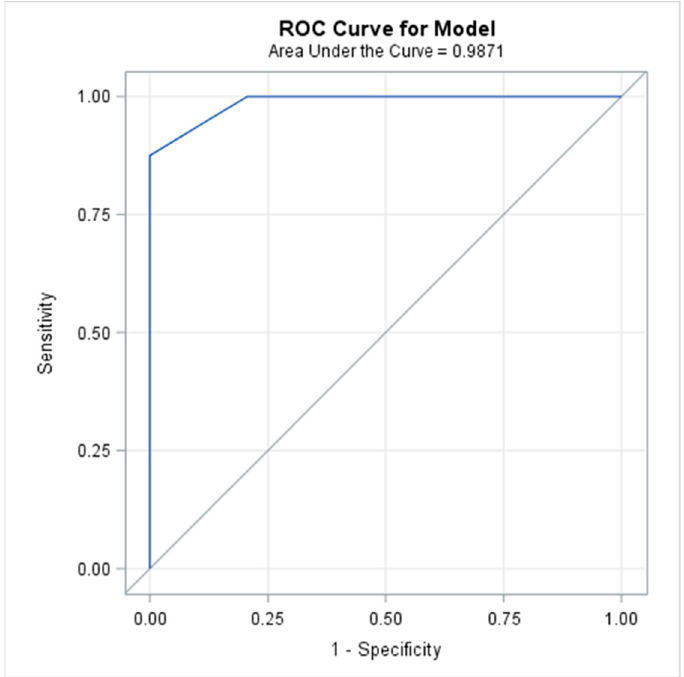
Figure 2. The Receiver Operating Characteristic (ROC) curve used to illustrate the relation between sensitivity and specificity, defined as the plot of sensitivity versus 1-specificity (false-positive rate) across different cut-off values.